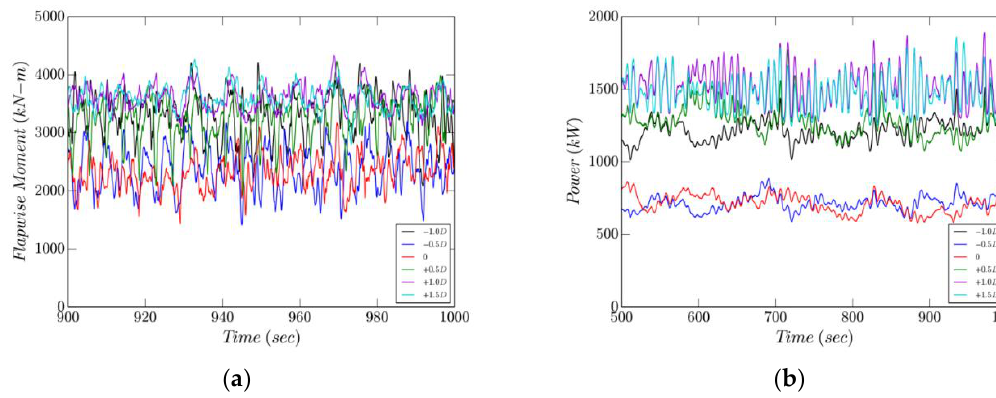
Figure 6. ( a ) WT2 power and ( b ) flapwise blade root moment for various lateral positions.